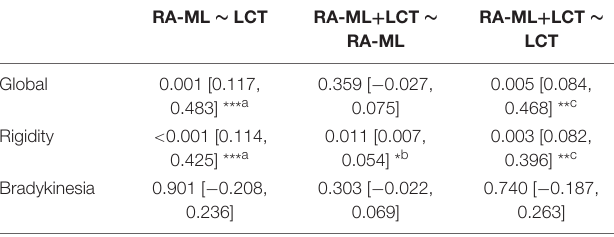
TABLE 3 | Comparison of ROC curves of the three predictive